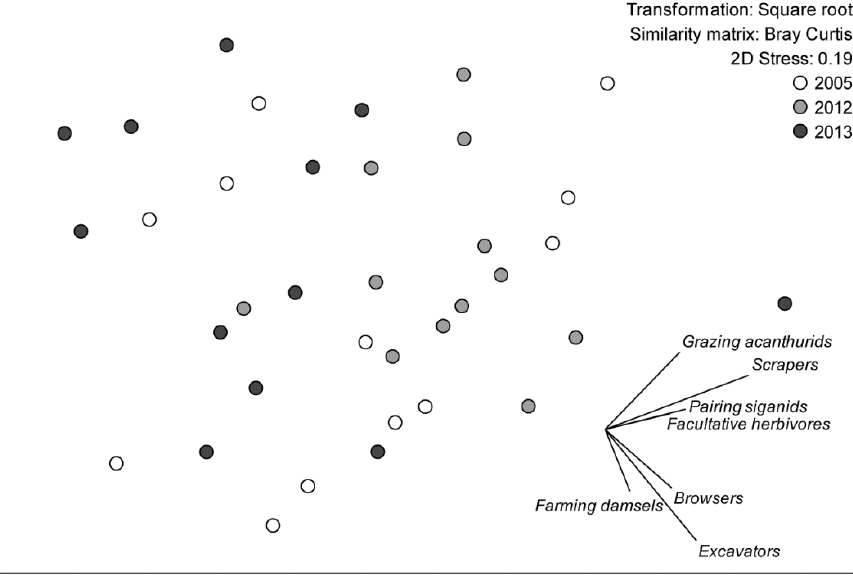
Figure A1.3. Functional group MDS of biomass data of seven functional groups of herbivorous fishes (see Table S1); vectors calculated using multiple partial correlations in PRIMER 6.0 PERMANOVA+. 1 way ANOSIM with sites pooled: Global R = 0.2. No groupings are